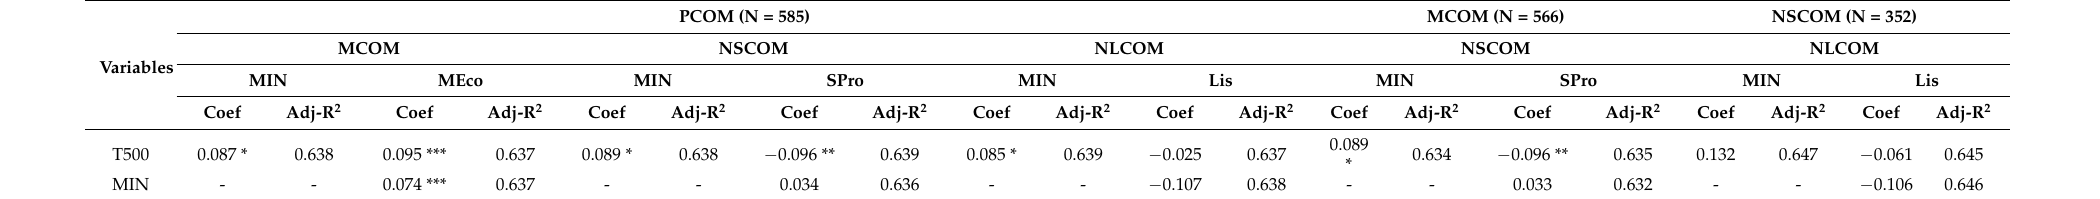
Table 8. Interactive regression results of the developer types (N =